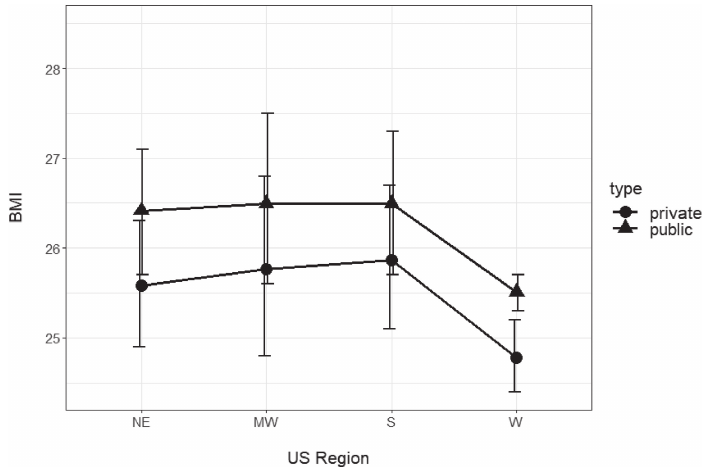
Fig. 2 Mean BMI of public versus private school students by US region. Note: Public school students self-report higher BMIs compared to private school students in all regions (p < 0.001). NE public n = 25,597 (overweight / obesity prevalence = 39.4%); NE private n = 53,554 (overweight / obesity prevalence = 29.9%); MW public n = 46,747 (overweight / obesity prevalence = 42.0%); MW private n = 30,818 (overweight / obesity prevalence = 33.9%); S public n = 65,741 (overweight / obesity prevalence = 40.5%); S private n = 23,509 (overweight / obesity prevalence = 31.5%); W public n = 129,714 (overweight / obesity prevalence = 40.3%); W private n = 29,307 (overweight / obesity prevalence =